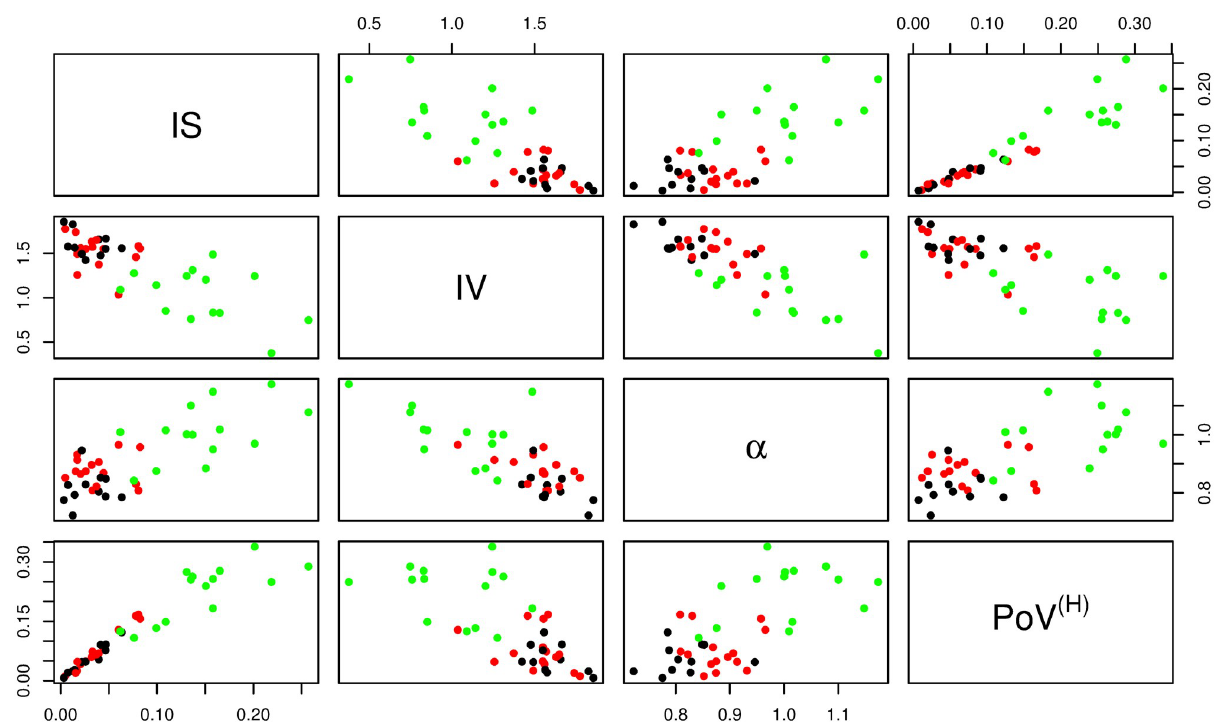
Fig 12. Scatter plots of all statistical measures. Scatter plots showing relationships between all possible pairs of the four statistical measures—IS, IV, the DFA scaling exponent ( α ), and PoV ( H ) . Participants from the non-intervention group, the intervention group, and the group of individuals without dementia, are represented by black, red and green dots respectively.